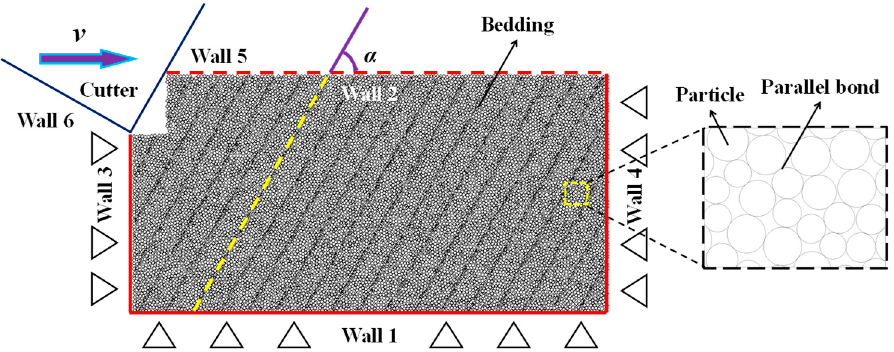
Figure 5. Discrete element model of a PDC cutter cutting shale.